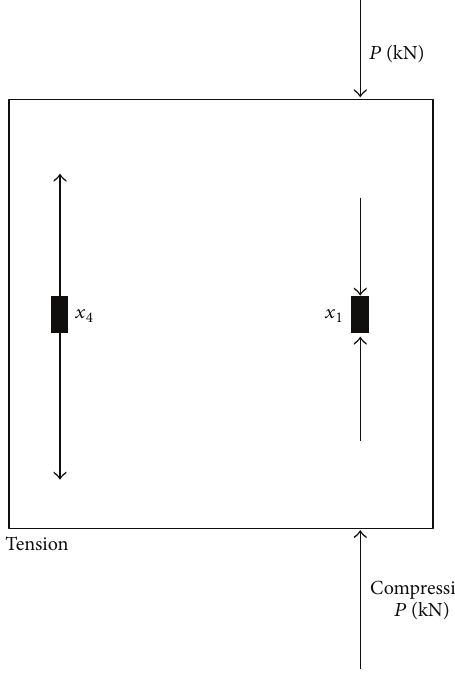
Figure 35: Behaviour of slab during Event